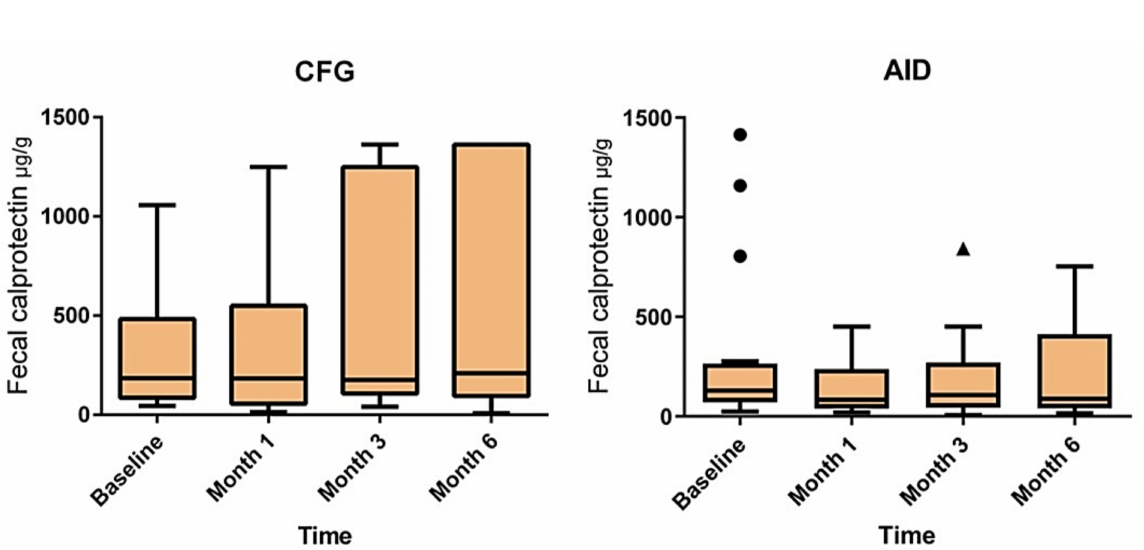
Figure 2. Changes in fecal calprotectin levels from baseline to the end of the trial. While there was a statistically significant increase in fecal calprotectin from baseline to month 6 or at time of relapse in patients randomized to the Canada’s Food Guide (CFG) diet ( p = 0.002), patients in the Anti-Inflammatory Diet (AID) showed a slight decrease in their fecal calprotectin levels during the same period ( p = 0.053). Each box shows the median and interquartile range values, and a Friedman test was used to compare FCP median values from baseline to the last visit in each group. Changes in FCP from baseline to the last visit between the two groups after adjusting for baseline FCP values was also statistically significant ( p = 0.02) using split-plot repeated measures